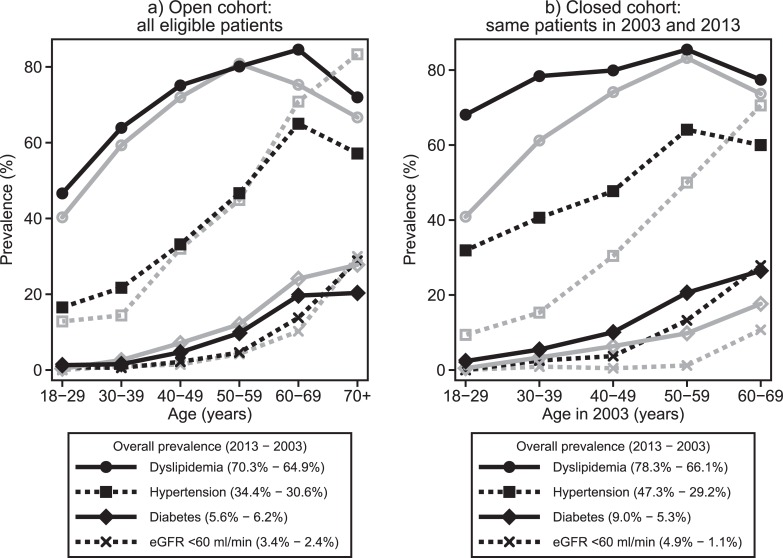
Prevalence of comorbidities in 2013 (black lines) and 2003 (grey lines) by age group in a) open cohort (all eligible patients) and b) closed cohort (subgroup of common patients in 2003 and 2013; results shown by their age in 2003). Six patients, aged 70+ in 2003, not shown in sub-figure b.